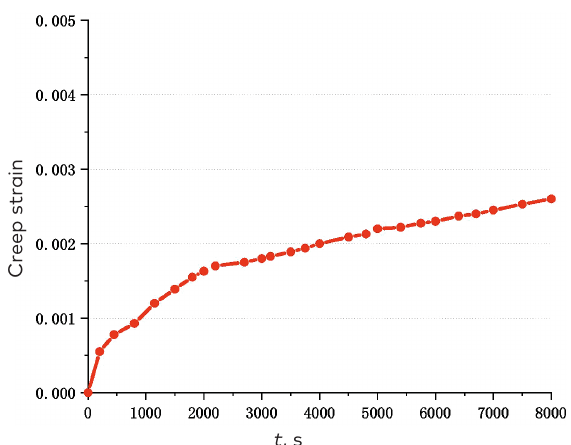
Figure 6. Creep curve under constant stress of 0.6